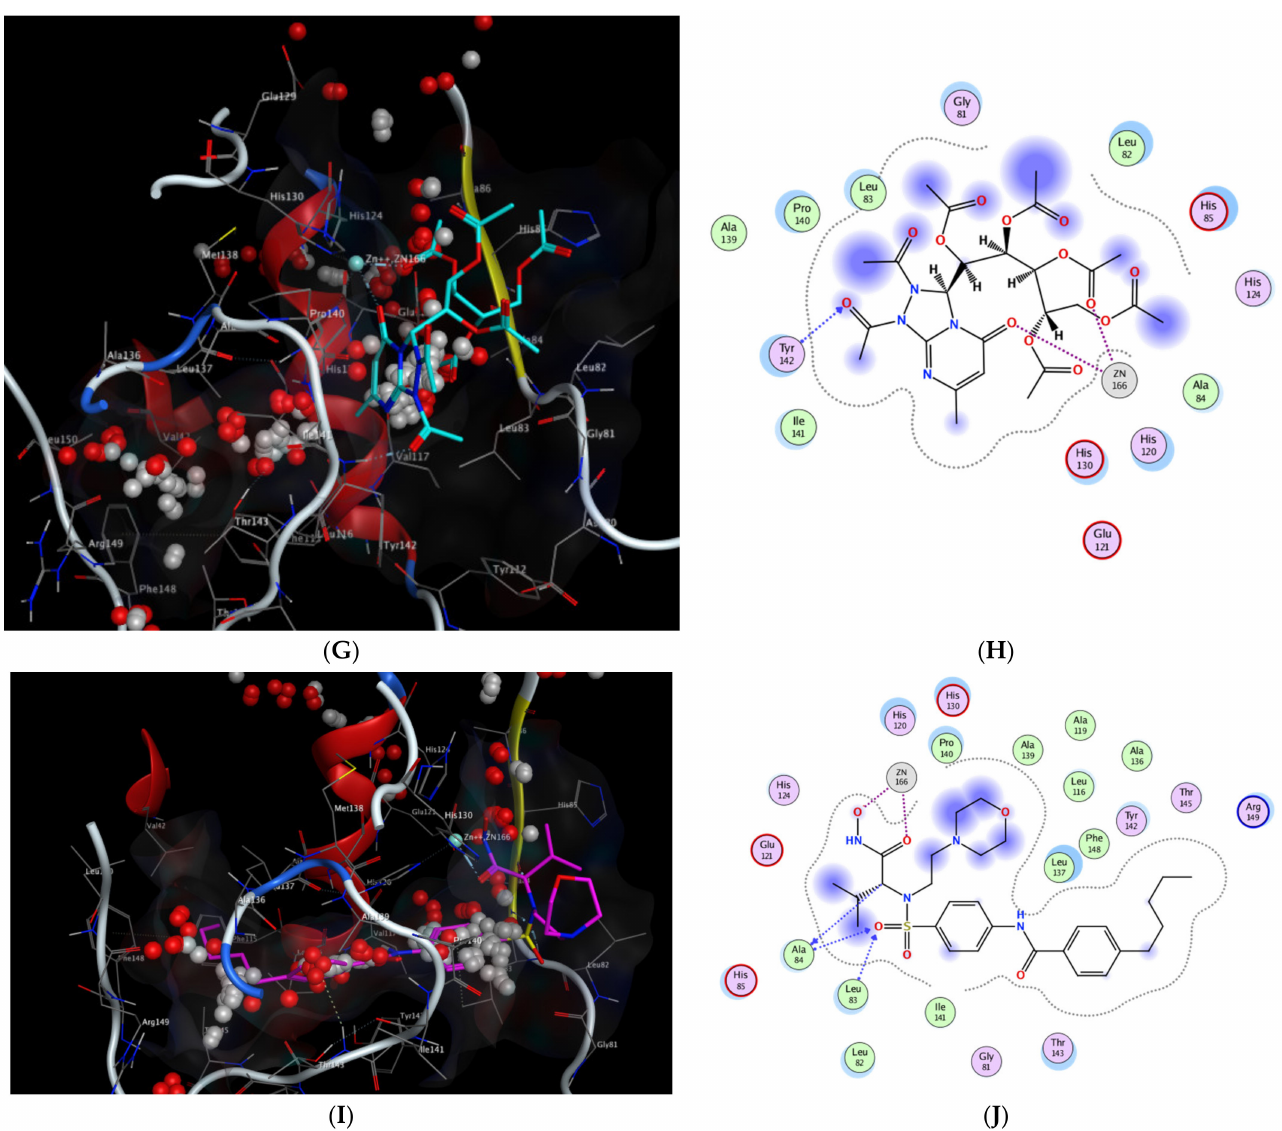
Figure 5. ( A ) The 3D binding mode of 8A (yellow sticks), ( B ) 2D binding mode of 8A , ( C ) 3D binding mode of 8B (green sticks), ( D ) 2D binding mode of 8B , ( E ) 3D binding mode of 9A (pink sticks), ( F ) 2D binding mode of 9A , ( G ) 3D binding mode of 9B (cyan sticks), ( H ) 2D binding mode of 9B, ( I ) 3D binding mode of the co-crystallized the hydroxamic acid inhibitor SC-74020 (magenta sticks), and ( J ) 2D binding mode of SC-74020 in the active site of MMP-2 (PDB ID: 1HOV